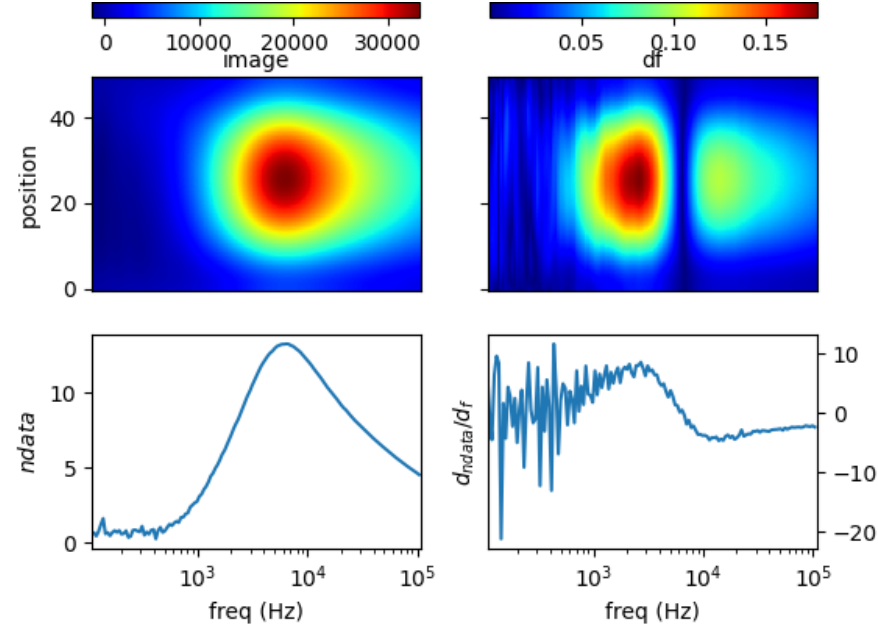
Figure 13. Spectral profile and its derivative (data and reconstructed image values) for brass ( σ = 16.1 MS / m) rod 0.25